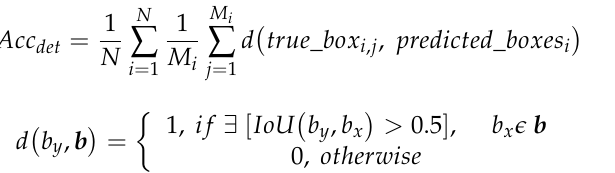
Table 2. Detection accuracy (20) of Selective Search on GTSDB data.